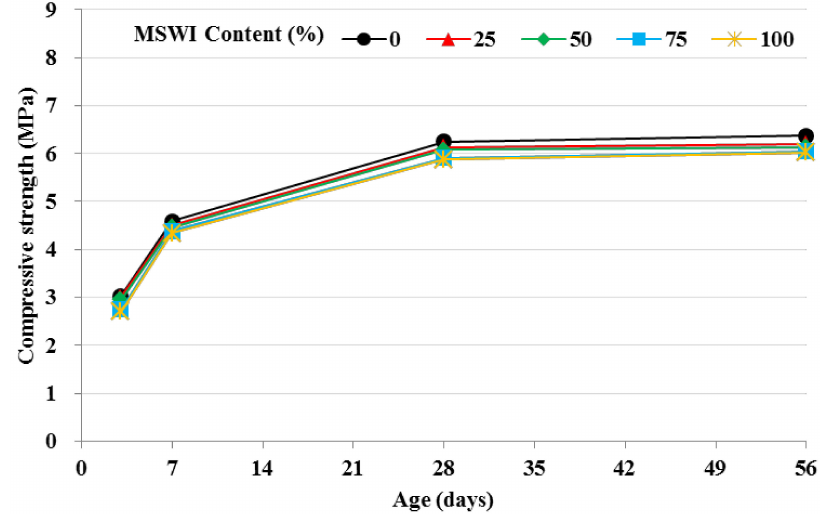
Figure 4. Effect of MSWI content on compressive